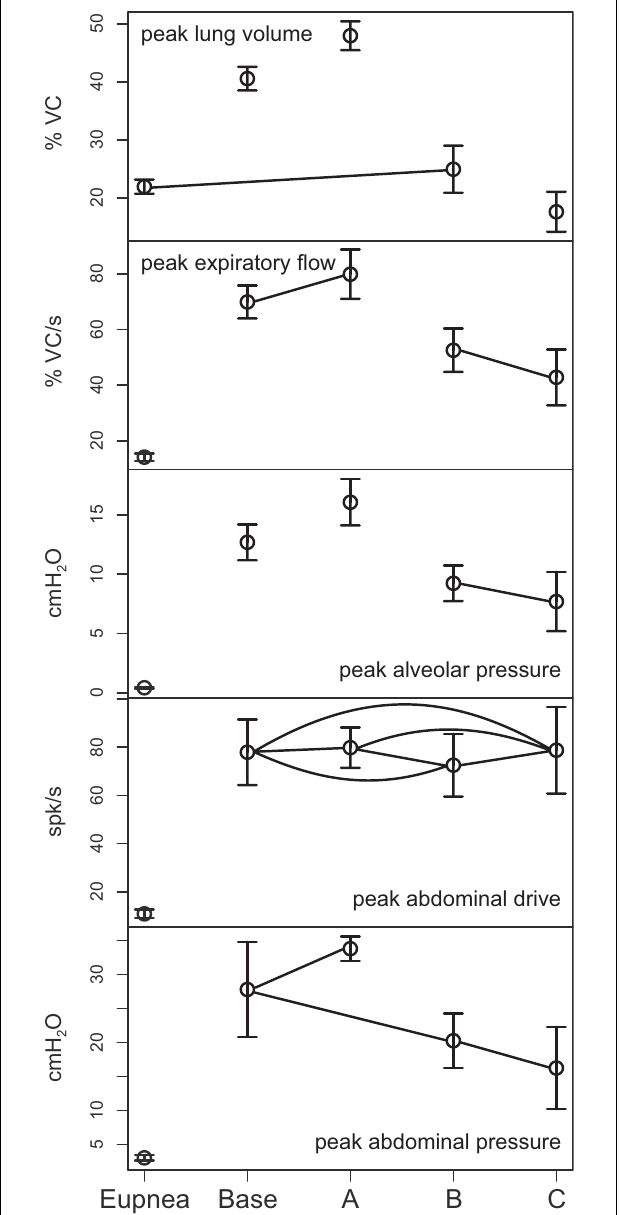
FIGURE 6 | Means of peak values ( ± 95% confidence limits) of (from top) lung volume, expiratory tracheal flow, alveolar pressure, abdominal drive, and abdominal pressure measured under conditions of pre-cough eupnea (Eupnea), baseline cough (Base), doubling of the synaptic strength between Cough 2nd order and the I-Aug and I-Aug-BS populations (A), elimination of Cough 2nd order excitation of the I-Aug and I-Aug-BS populations (B), and additionally, the subsequent elimination of I-Dec_2 neuron inhibition of E-Dec-Tonic neurons during the inspiratory phase of the evoked cough cycle (C). Pairs of symbols connected by a line indicate no significant difference.